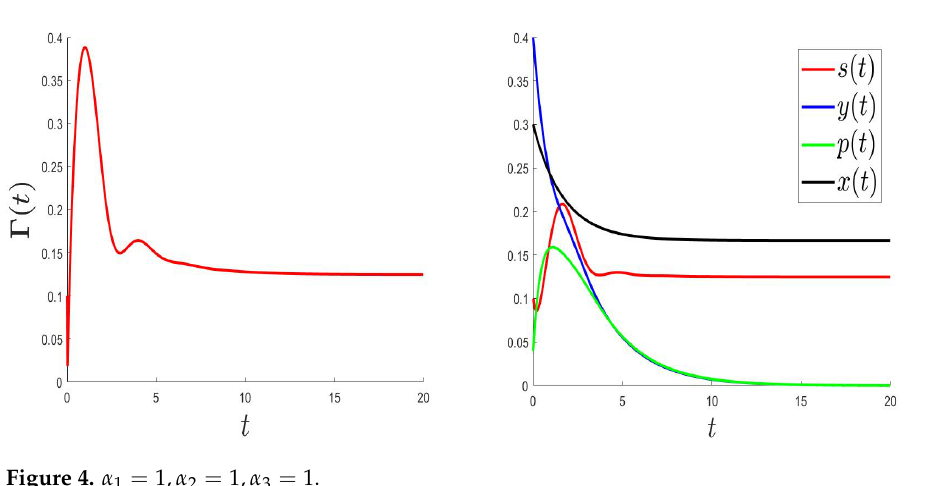
Figure 4. α 1 = 1, α 2 = 1, α 3 = 1.